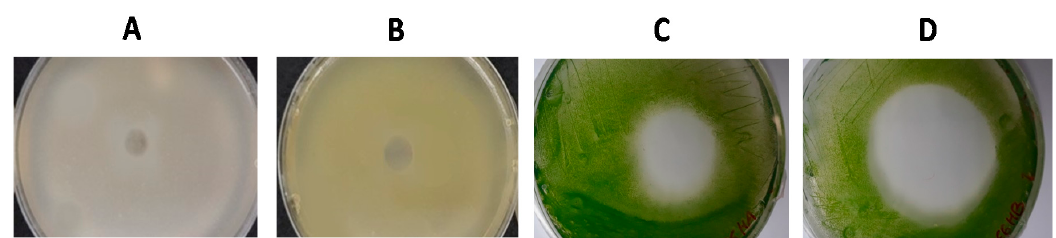
Figure 4. Antimicrobial activity of acetone extracts. Antimicrobial activity was indicated by zones of inhibition of growth or halos. Taking into account the diameter of the halo, the susceptibility of the different microorganisms to the extracts was classified in four reference groups: ( A ) 0.5–1 cm (+) in Bacillus cereus ; ( B ) 1–2 cm (++) in Staphylococcus aureus ; ( C ) 2–4 cm (+++) in Dunaliella bardawil and ( D ) 4–6 cm (++++) in Dunaliella salina . Table 1. Antimicrobial activity of acetone extracts.